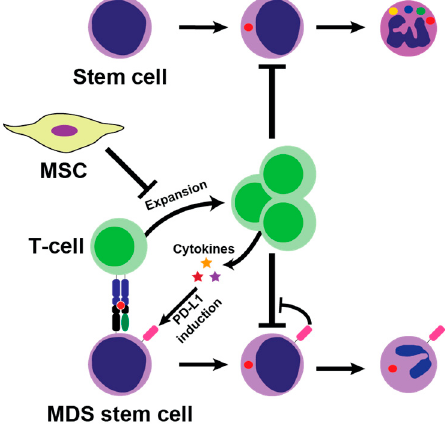
Figure 1. Potential mechanism of bone marrow suppression by T-cells. CD8+ T-cells are activated by major histocompatibility complex (MHC)-class I complex on malignant MDS stem cells, which leads to T-cell expansion which in turn suppress hematopoiesis. T-cells secrete proinflammatory cytokines such as tumor necrosis factor (TNF)- α and interferon gamma (IFN)- γ into the bone marrow microenvironment, which may both hinder hematopoiesis and induce PD-L1 on tumor cells hereby promoting escape from tumor surveillance. Normally, mesenchymal stromal cells (MSC) suppress T-cells activation in the bone marrow by paracrine and cell-to-cell interaction, but these mechanisms may be flawed in myelodysplastic syndrome (MDS).